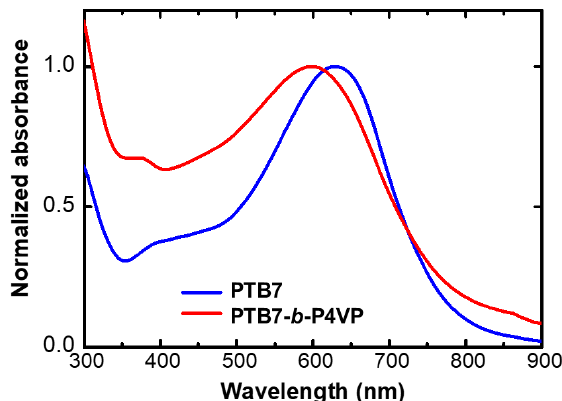
Figure 2. Comparison between the spectra of homemade PTB7 (blue) and of PTB7- b -P4VP (red) dissolved into chloroform.